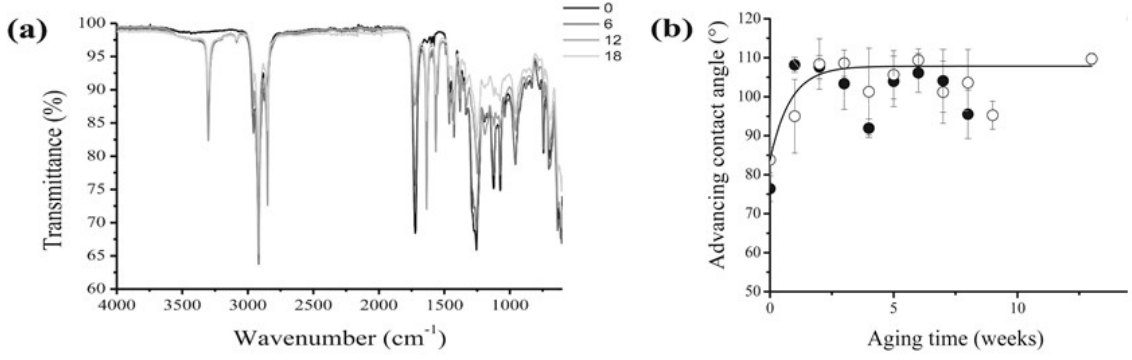
Figure 4. ATR-FTIR spectra measured for cleaned 30-year-old PVC at different durations (in weeks) of artificial thermal ageing ( a ) and evolution of the advancing contact angle as a function of the artificial ageing time for an as-collected ( ○ ) and a cleaned ( ● ) 30-year-old PVC film in an open environment ( b ). Image reprinted with permission from [54].